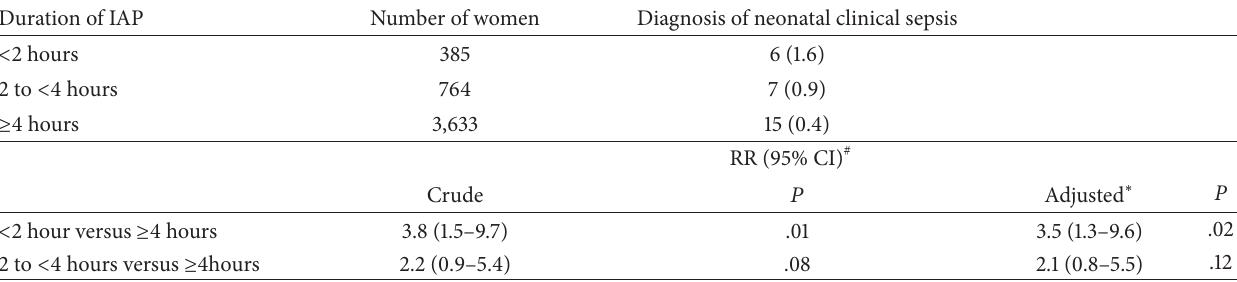
Table 2: Effect of the duration of intrapartum antibiotic prophylaxis on the diagnosis of neonatal clinical